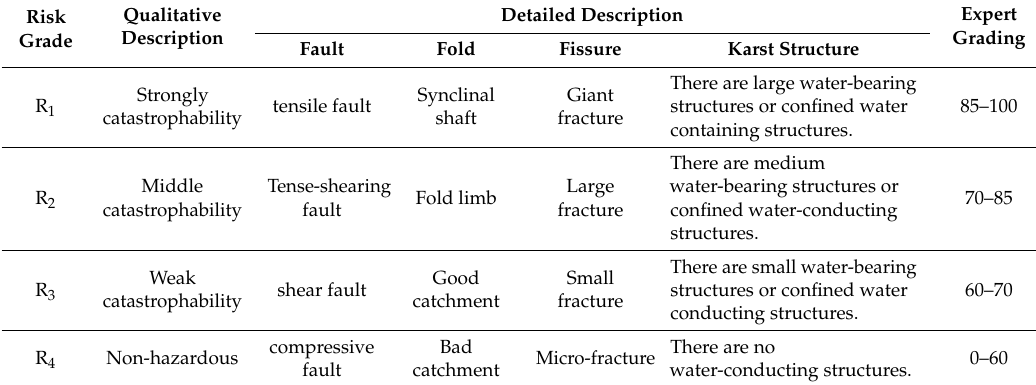
Table 2. Grade division criteria for bad